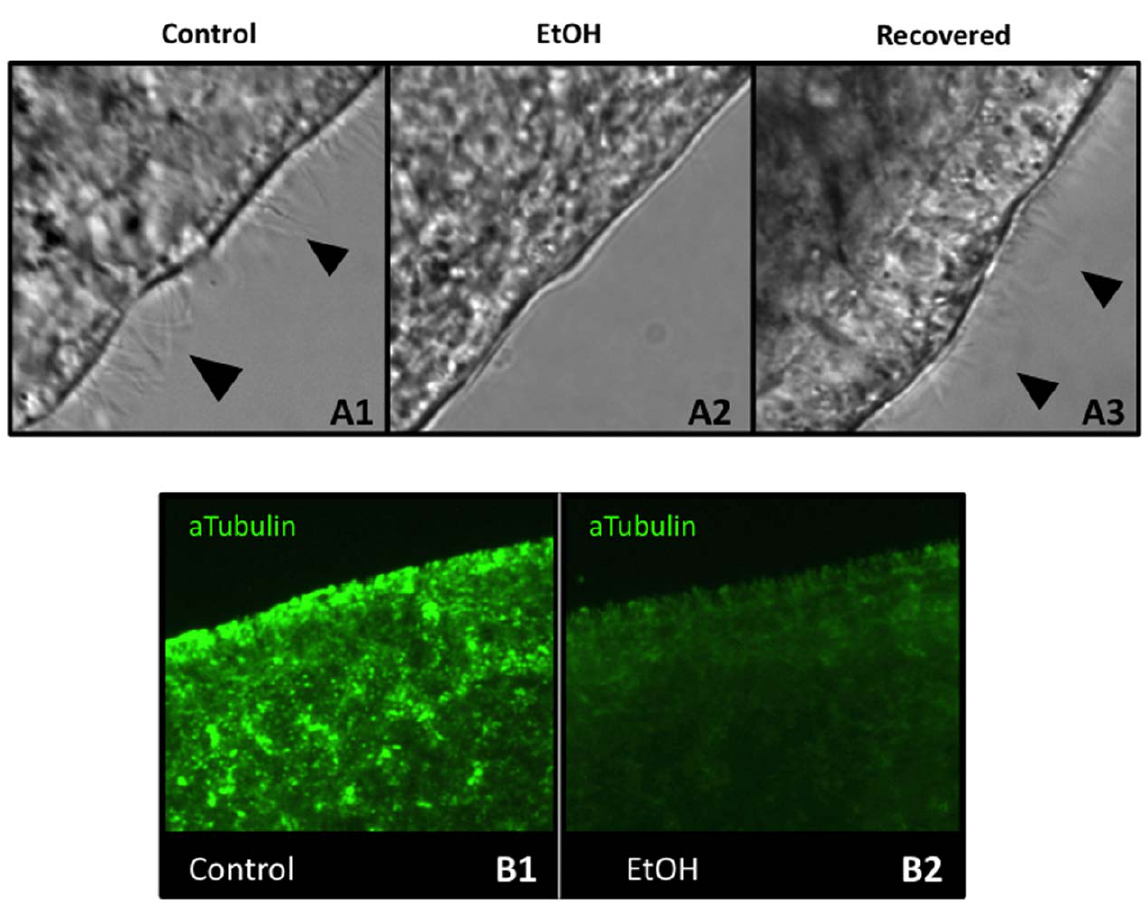
Figure 7. A 3% Ethanol Treatment Removes Epithelial Cila. ( A ) Analysis of Cilia in the Head Region . (A1) Untreated control worms are ciliated. (A2) After a 1-hour EtOH treatment, worms have become deciliated. (A3) After 4 hours of recovery, EtOH-immobilized worms are again ciliated. n=11 for each. Black arrowheads = cilia. ( B ) Anti-acetylated tubulin staining of cilia on the ventral surface . (B1) Control worms are heavily ciliated (bright green staining). (B2) After a 1-hour EtOH exposure, epidermal ciliary staining is lost. Pre-pharyngeal region is shown. doi:10.1371/journal.pone.0015310.g007 image that remains in register (Figure 8C). Our data showed that EtOH immobilization for live imaging with reporter dyes can be there were no adverse effects on either cell membrane integrity or combined with subsequent tracking of worms over time for scoring later regeneration (even with repeated exposures), suggesting that or re-imaging.